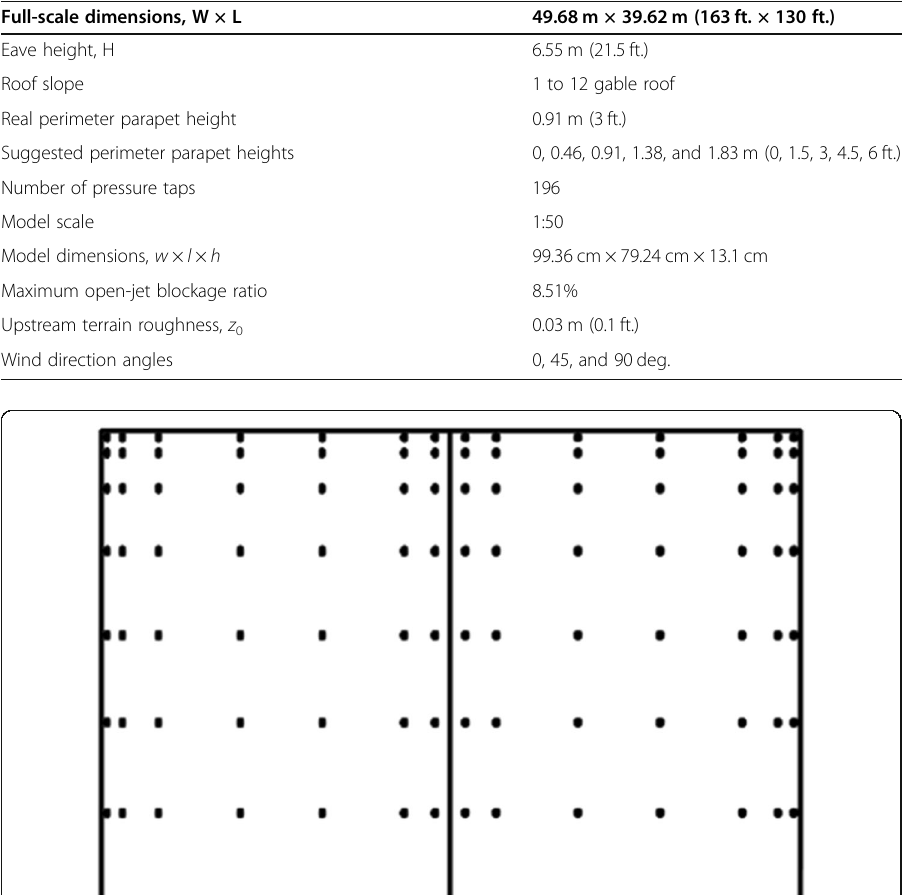
Table 1 Details of the building case study and the aerodynamic experiment